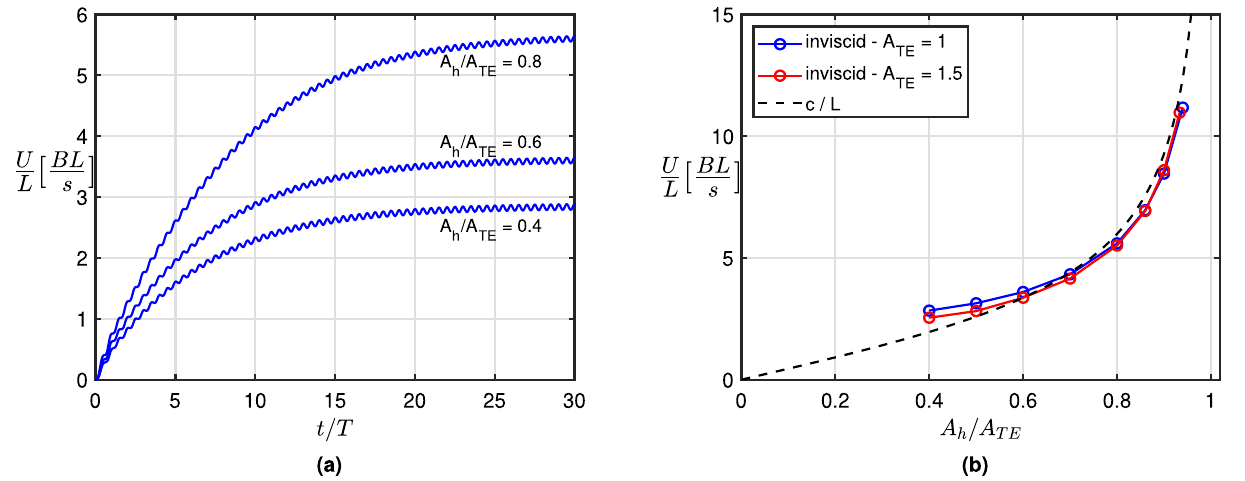
Figure 2. ( a ) Time history of the locomotion speed for A TE = 1 and three different values of A h ∕ A TE . (2b) Mean steady state swimming velocity U / L and phase velocity c / L (dashed line) against A h ∕ A TE for different peak-to-peak trailing edge oscillation amplitudes ( A TE = 1 and 1.5). Inviscid numerical results for zero resistance of the virtual